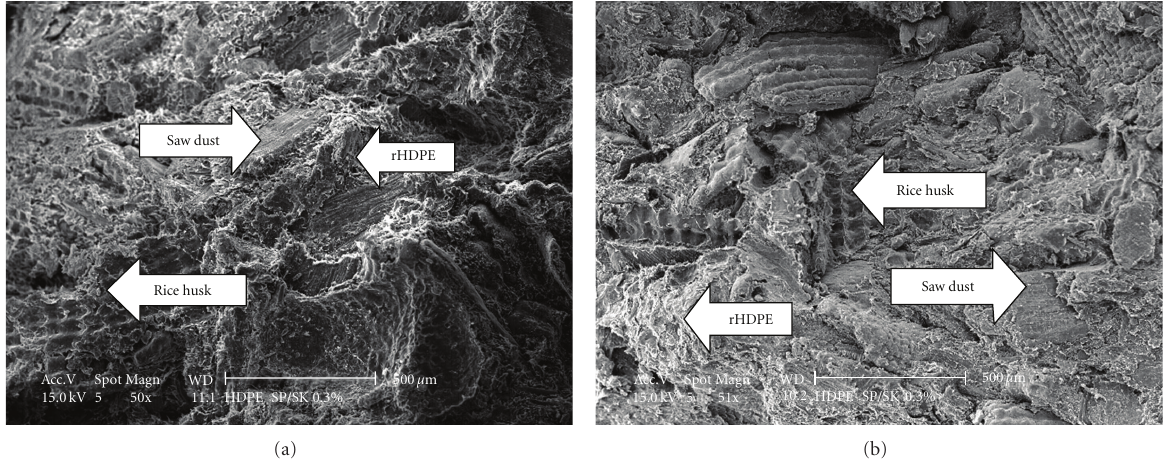
Figure 4: SEM photographs of sample produced by (a) counterrotating twin-screw extruder and (b) corotating twin-screw extruder.